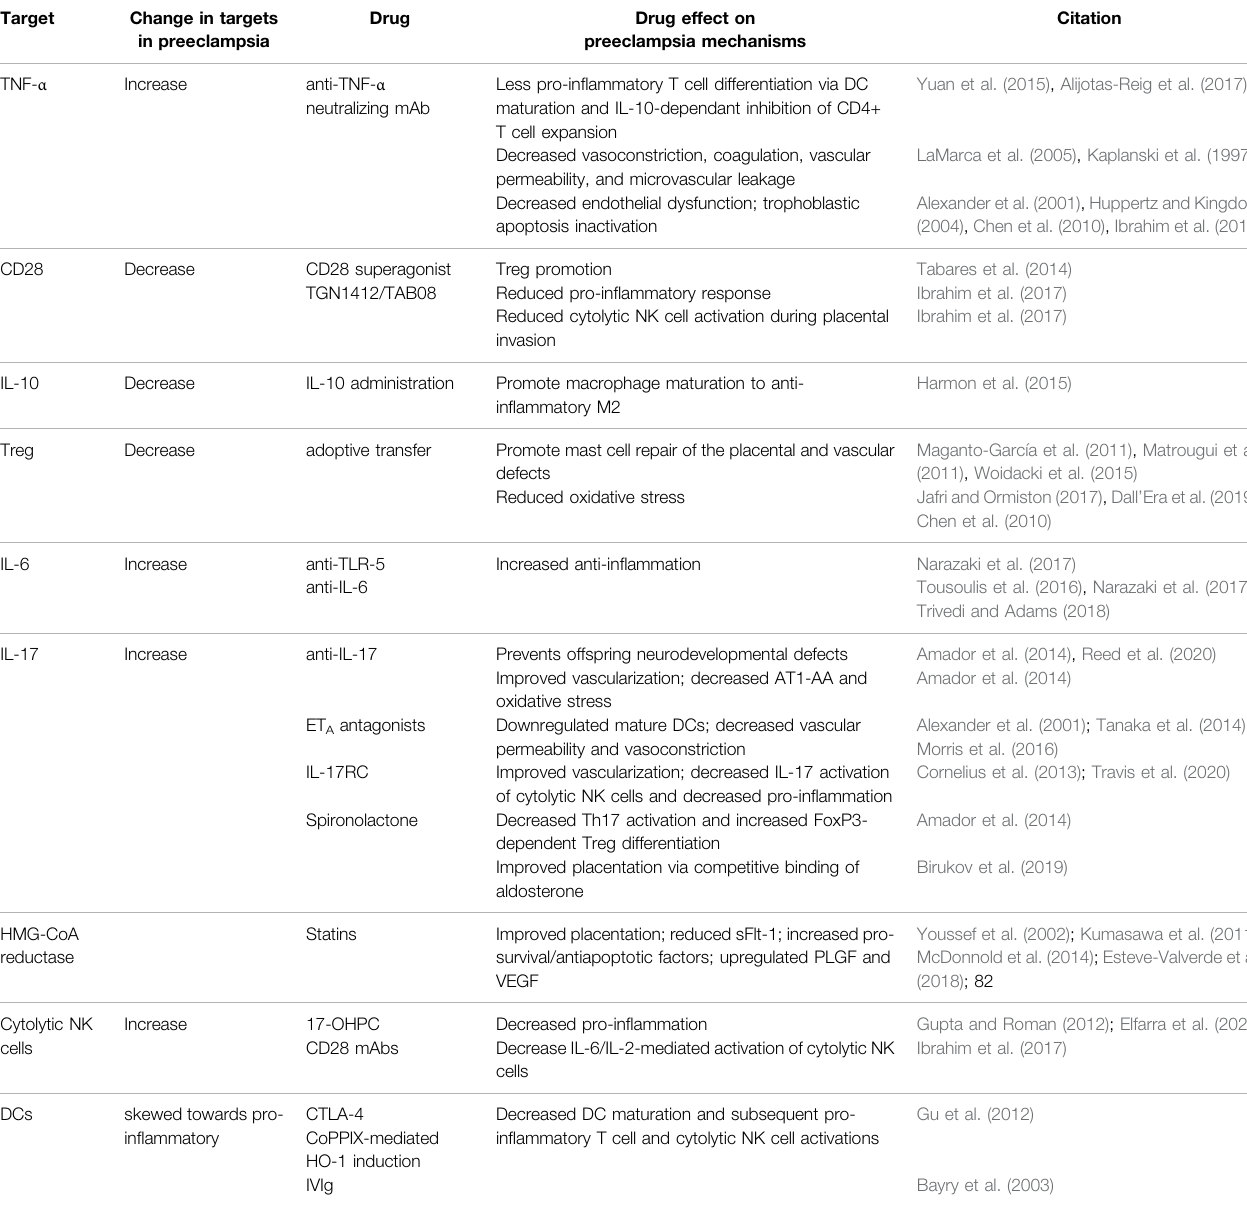
TABLE 1 | Immunomodulation offers promise for preeclampsia (PreE) prevention. This table describes potential preeclampsia prevention targets, the directionality of target abnormality in PreE, drugs that modulate the targets, and the effects of each drug on PreE-related biological processes. Treg, regulatory T cell; NK, natural killer; DC, dendritic cell; CTLA-4, cytotoxic T lymphocyte-associated antigen-4; IVIg, intravenous immunoglobulin G; ET A , endothelin-1 receptor A; anti, antibody; CoPPIX, cobalt protoporphyrin; HO-1, heme oxygenase 1, mAbs, monoclonal antibodies; Th, Helper T cell; Treg, regulatory T cell; IL, interleukin; IFN- γ , interferon gamma; TNF- α , tumor necrosisfactoralphasFlt-1,solubleFms-likeTyrosineKinase-1;PLGF,placentalgrowthfactor;VEGF,vascularendothelialgrowthfactor;IL-17RCmouseIL-17receptor C;17-OHPC,17-hydroxyprogesteronecaproate;NK2,non-cytolytic,type2NaturalKillercells;NK1,cytolytic,type1NaturalKillercells;TLR5,tolllikereceptor fi ve;AT1- AA, Angiotensin II Type 1 Receptor Agonistic